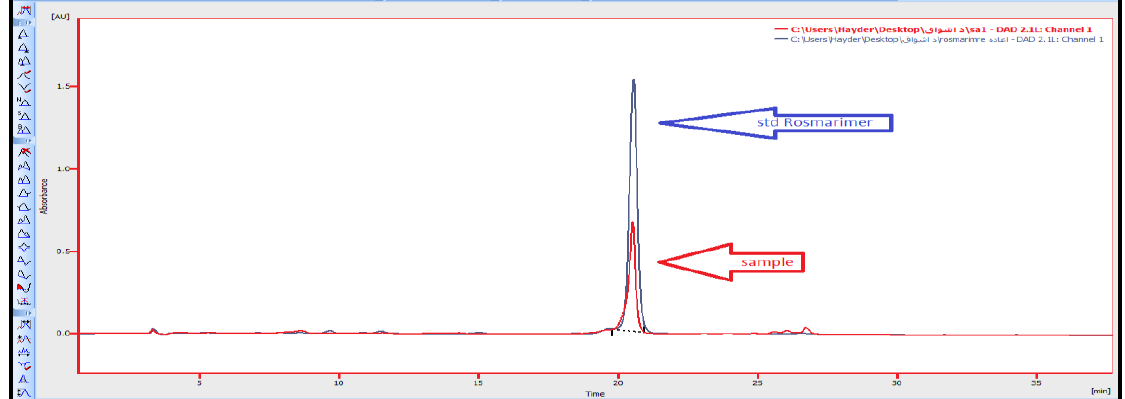
Figure 14. HPLC chromatogram of isolated compound number 1 and Rosmarinic acide